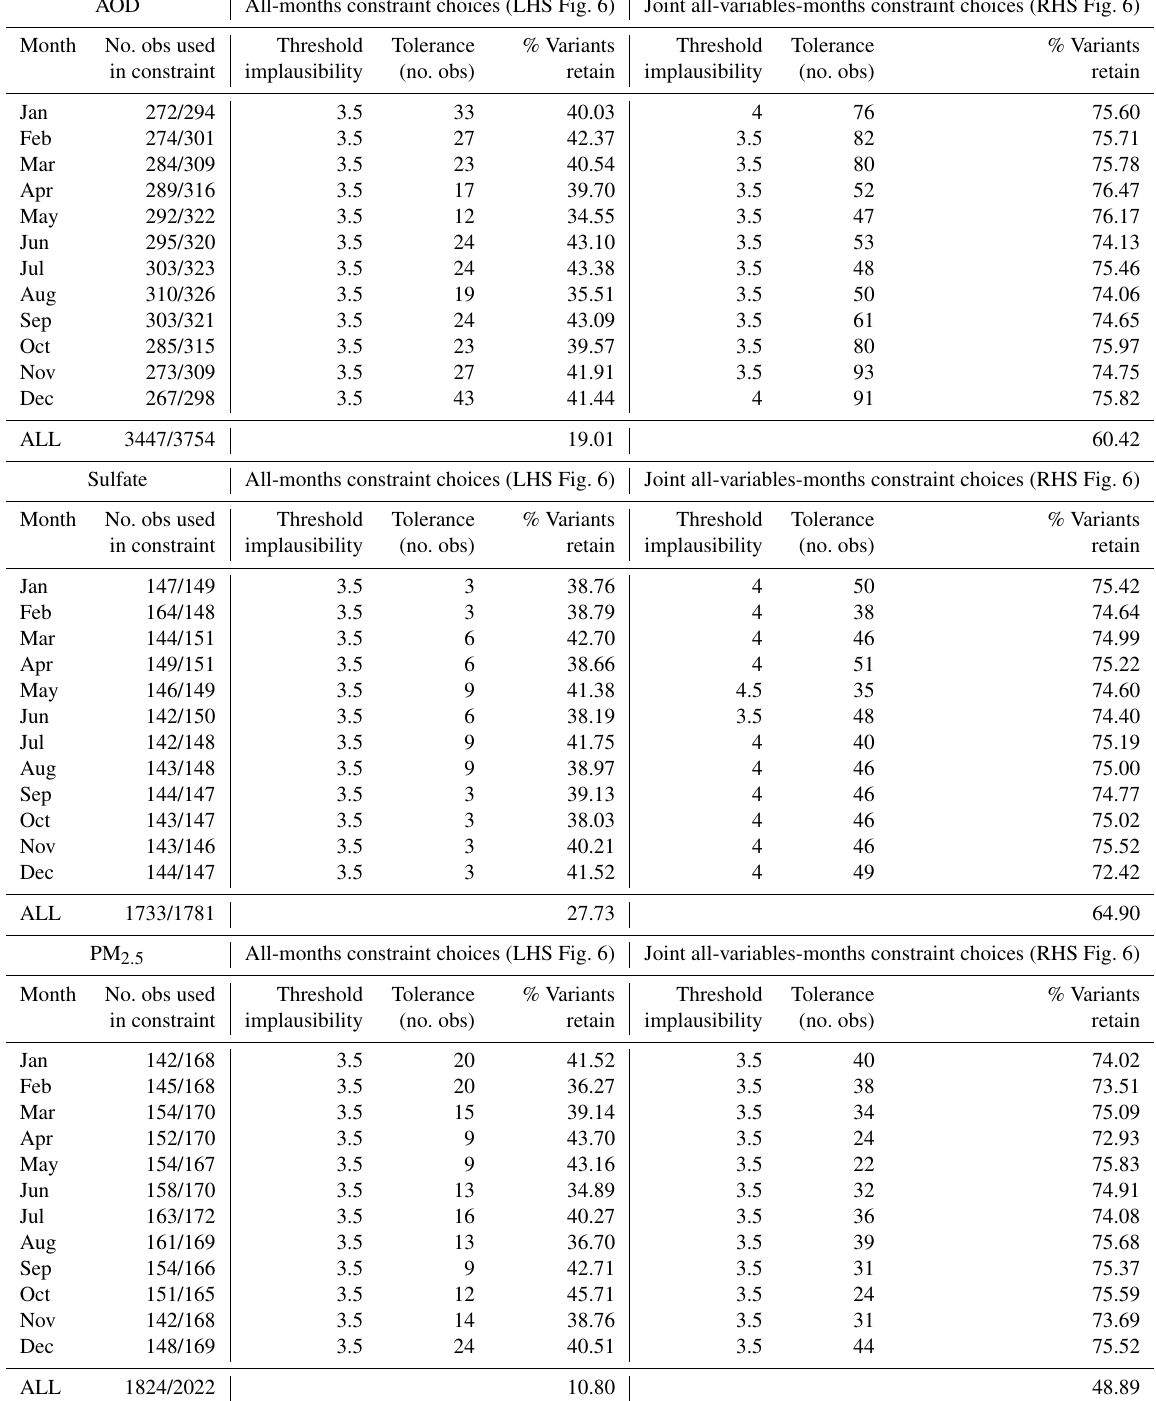
Table A2. The choices of the number of measurements (tolerance, T ) allowed to exceed a threshold implausibility ( θ ) for constraint on each of the monthly observed aerosol properties, along with the corresponding percentage of the large sample of 1 million model variants (that covers the PPE parametric uncertainty) that is retained on constraint for each choice. The choices on the left correspond to those used for the all-months constraints shown on the left of Fig. 6. The choices on the right correspond to those used for the joint all-variables-months constraint shown on the right in Fig. 6. The percentage of variants retained is also shown for the combined all-months constraint for each variable (ALL) as well as for the joint all-variables-months constraint (final row). LHS indicates the left-hand side and RHS the right-hand